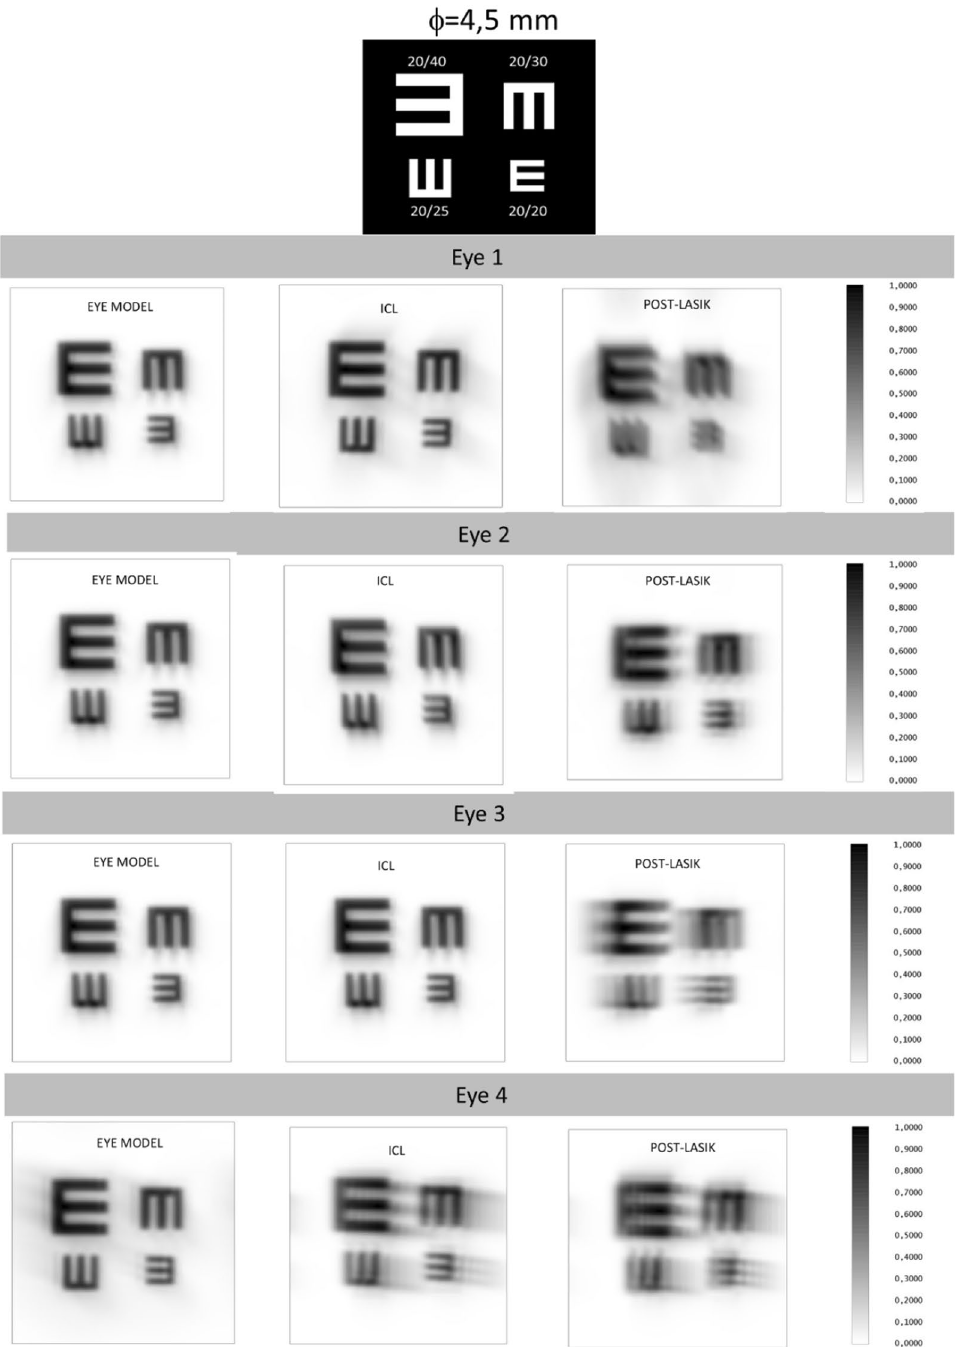
Figure 6. Simulated vision of the optotypes of the three eye models (eye model, ICL model and post-LASIK model) for the pupil size of 4.5